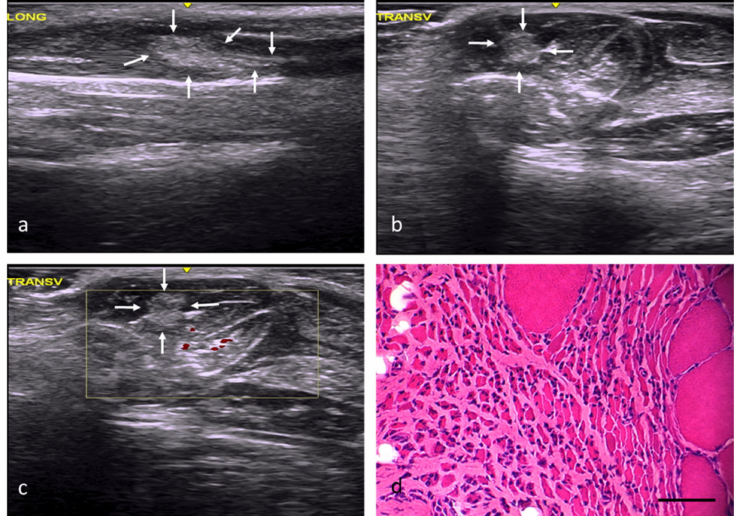
Figure 5. OS group. ( a ) Longitudinal axis, with images of a well-defined injury with increased echogenicity and a clearly distorted echostructure compared with the adjacent tissue. ( b ) Transverse axis, with images of an oval injury with well-defined margins. ( c ) Transverse section assessed by power Doppler imaging, with images of slightly increased perilesional vascularization. ( d ) Transverse section representative of the muscle histology. H-E. Size scale: 100 µ